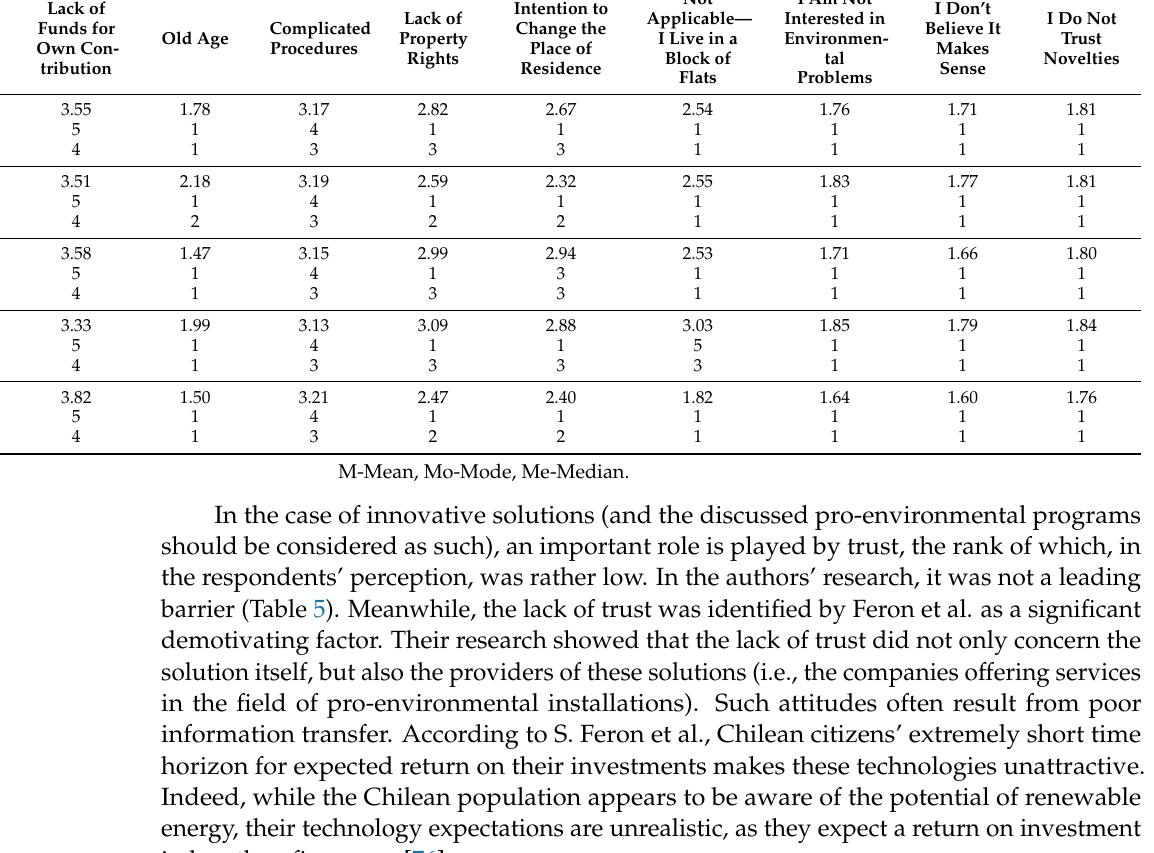
Table 5. Factors discouraging respondents from participating in pro-environmental programs, by age and place of residence (5-point Likert scale, where 1-the least discouraging and 5-the most discouraging).